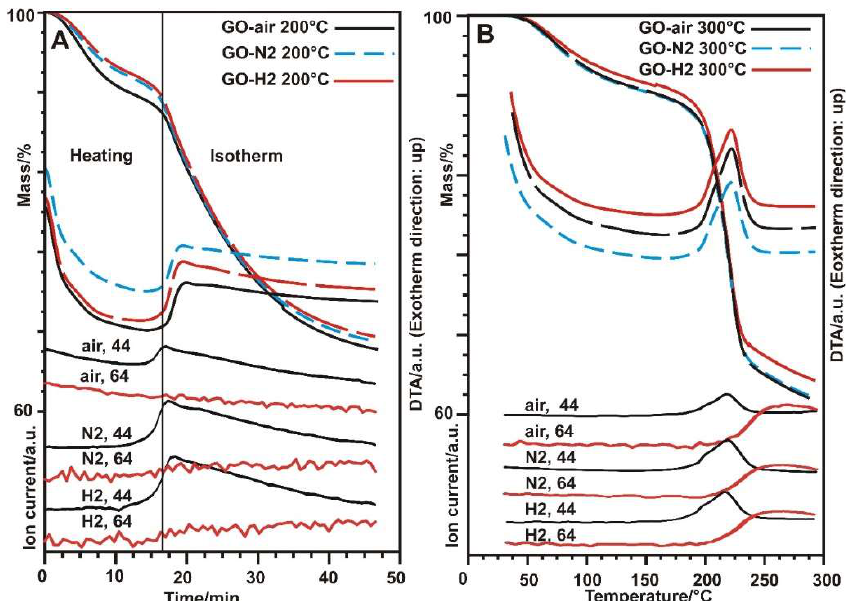
Figure 2. TG/DTA-MS measurements of the GO in different atmospheres to 200 °C ( A ) and 300 °C ( B ) (black: GO-air, blue: GO-N2, red: GO-H2, ion currents: black: 44 m/z, red: 64 m/z).